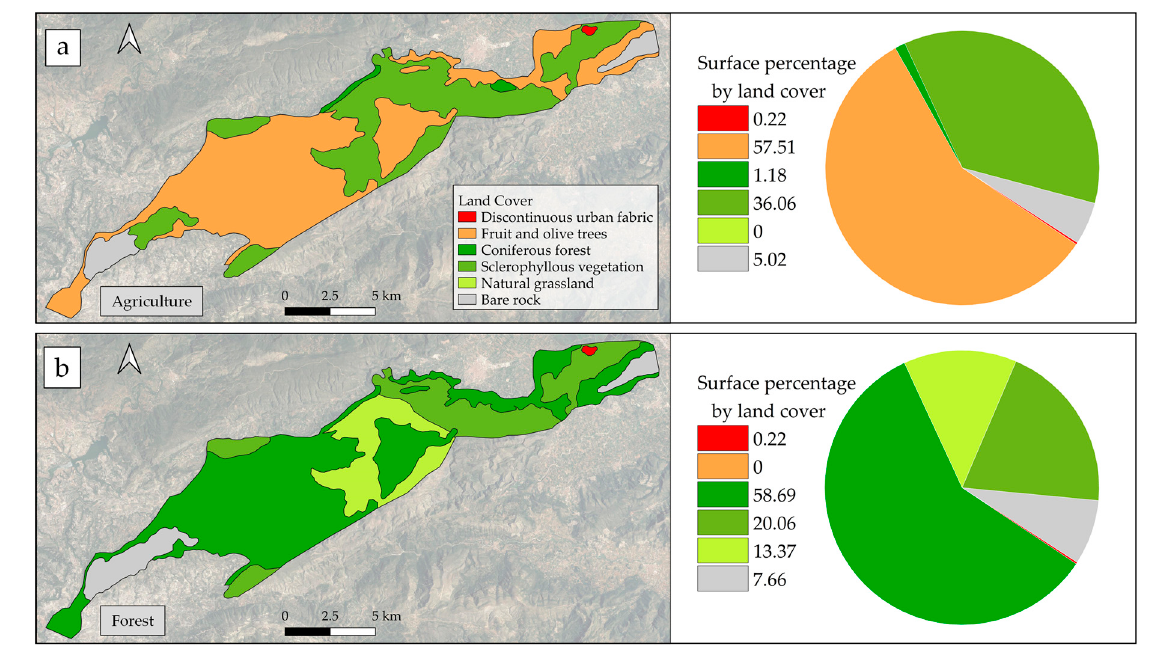
Figure 3. Spatial distribution of land covers and the corresponding surface percentage for both hy- pothetical scenarios: ( a ) agriculture-dominated land cover; and ( b ) forest-dominated land cover.